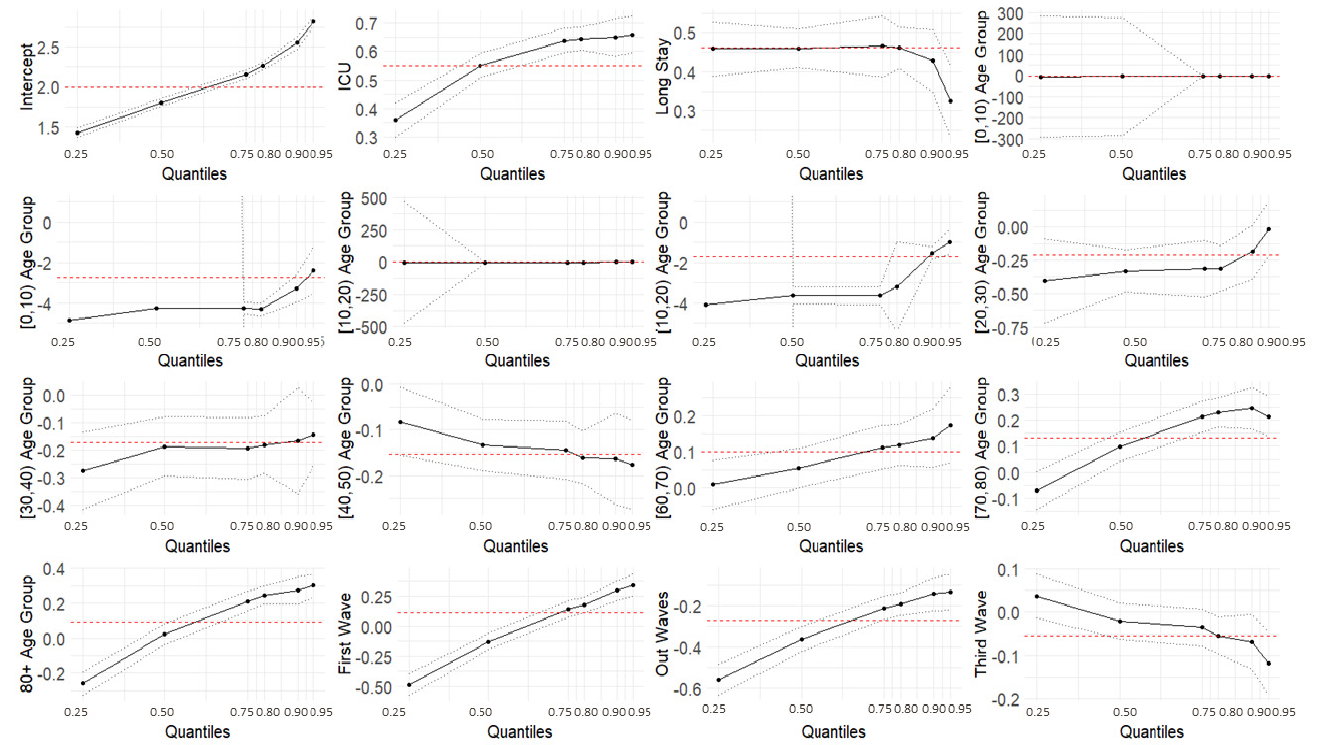
Figure 7. Quantile regression models.